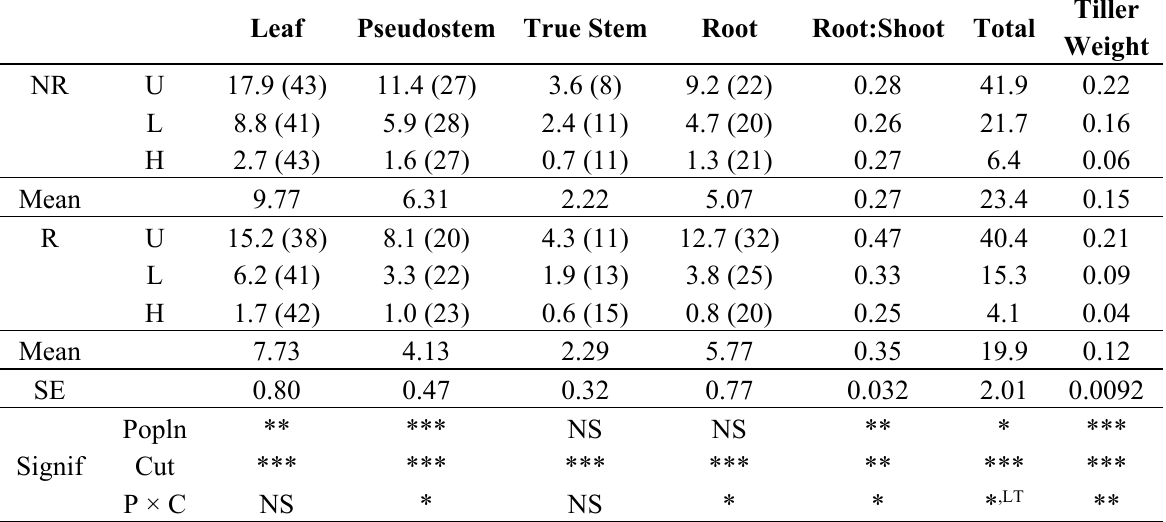
Table 1. Contribution of tiller components to plant weight (g DM) of non-rhizomatous (NR) and rhizomatous (R) tall fescue populations undefoliated (U), or under lax (L) or hard (H) defoliation treatments.